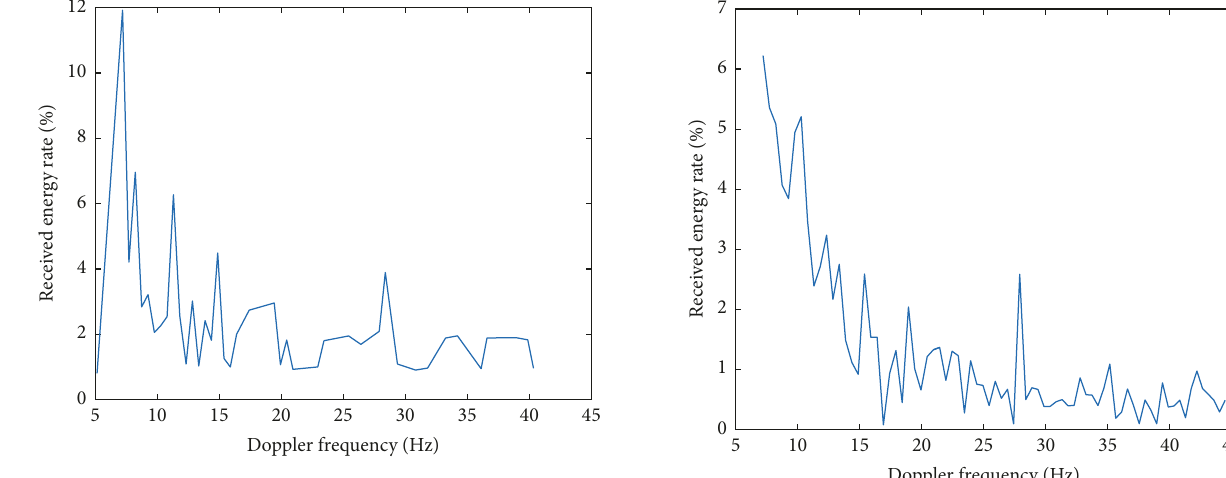
Figure 5: Simulation result when 𝑁 = 100 .